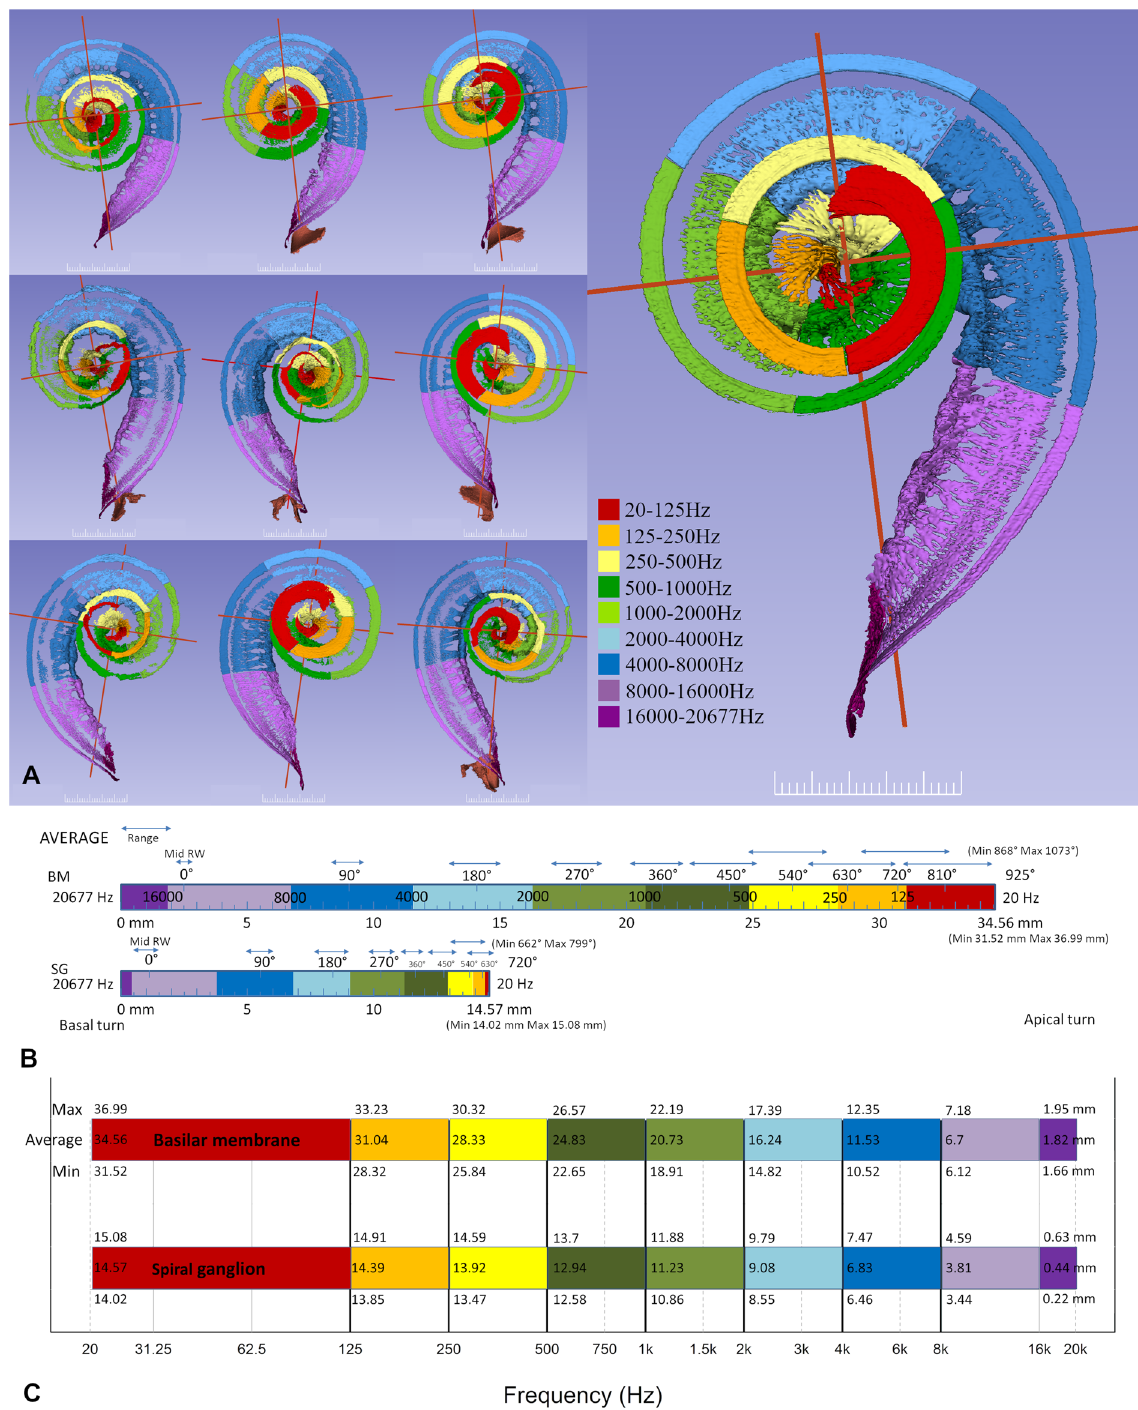
Figure 2. ( A ) Segmentations of soft tissues from ten cochleae shown in orthographic 3D view. 3D Slicer (www. slice r.org, version 4.10.1) 13 was used to create the 3D representations. Frequency maps of the basilar membrane were developed according to Greenwood 14 . Corresponding dendrites were traced to the spiral ganglion and corresponding octave bands are outlined. Scale bar is 2.5 mm. ( B ) Average rotational angles for tonotopic frequencies of the BM and SG. Angular rotations are calculated from the mid-point of the round window. Ranges in position of angular rotations are shown with blue arrows. ( C ) Average length of BM and SG presented against frequency for all cochleae. Values within the color bars represent the mean distance to reach each tonotopic frequency, with values along the top and bottom of the color bars representing the maximum and minimum distances to reach each frequency,